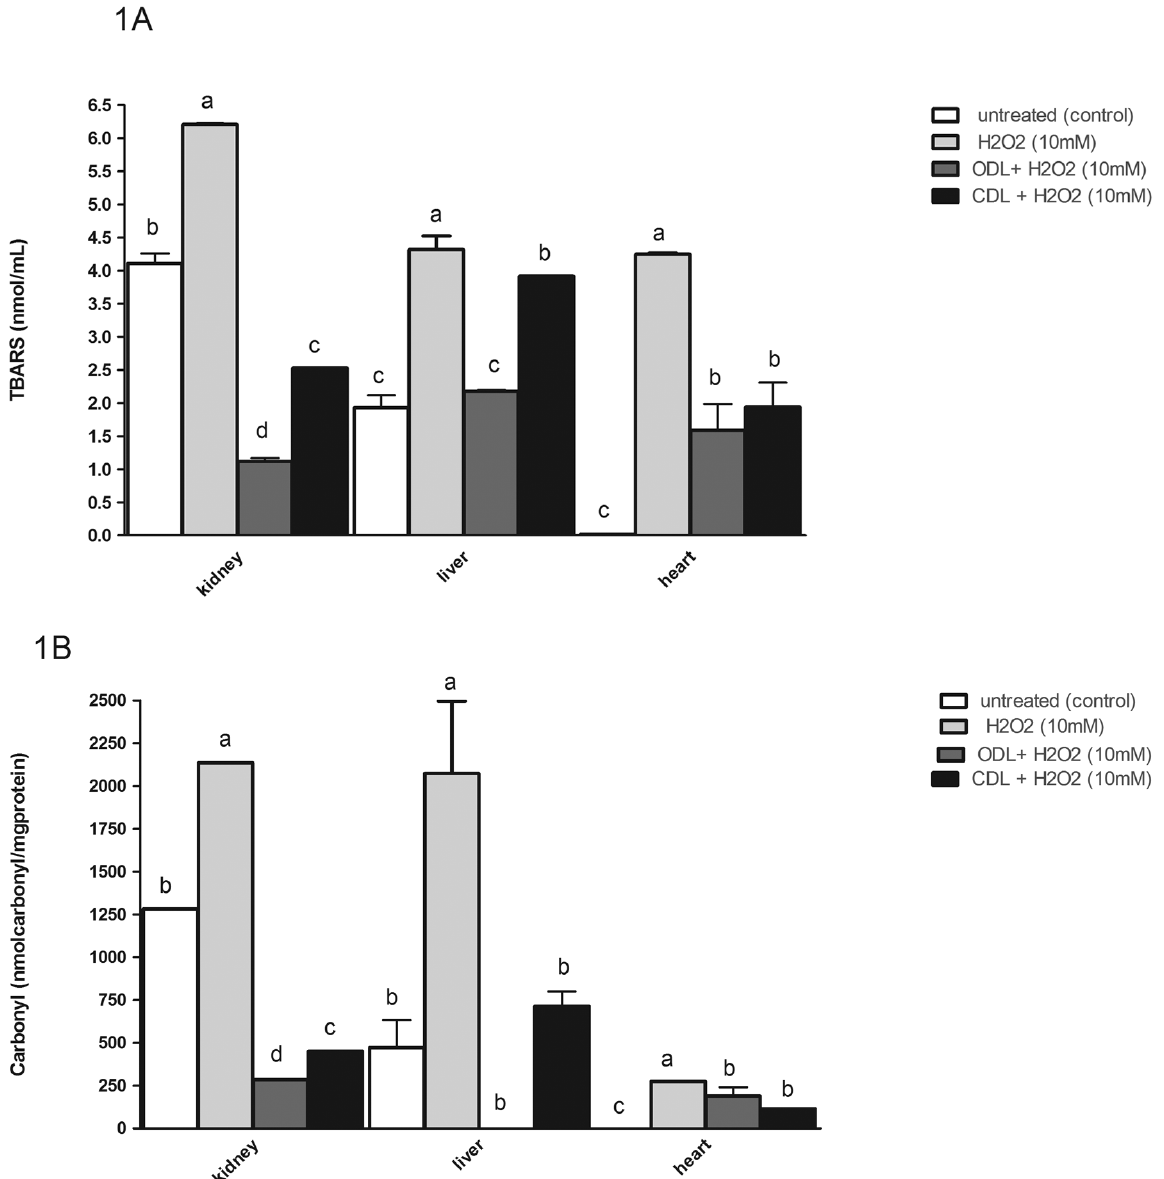
Fig. 1 – TBARS (A) and carbonyl (B) levels in kidney, liver and heart tissues of Wistar rats treated with organic and conventional grape leaf extracts. Data are mean ± SD values of two independent experiments. *Different letters indicate a significant difference according to the analysis of variance and Tukey’s post-hoc test (p = 0 . 05) for each tissue evaluated; for example, a is different from